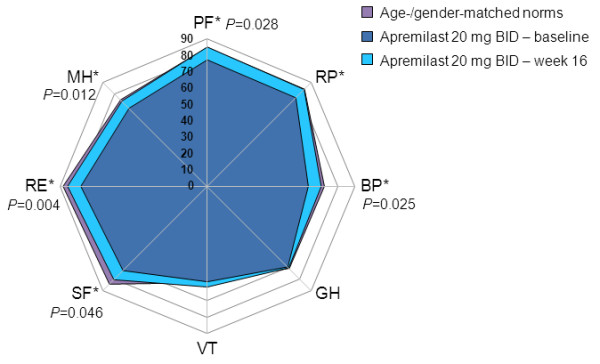
SF-36 domain scores at baseline and week 16 with apremilast 20 mg BID. Spydergram of SF-36 domain scores in patients receiving apremilast 20 mg BID versus US age-/gender-matched norms (lavender) and baseline (dark blue). Gridlines represent changes of 10 points each (10 points = 2× MCID). An increase in score indicates improvement. Treatment-associated improvements (light blue) are statistically significant in five and ≥MCID in six of eight domains. MCID, minimal clinically important difference; SF-36, 36-item Short-Form Health Survey. *≥MCID.